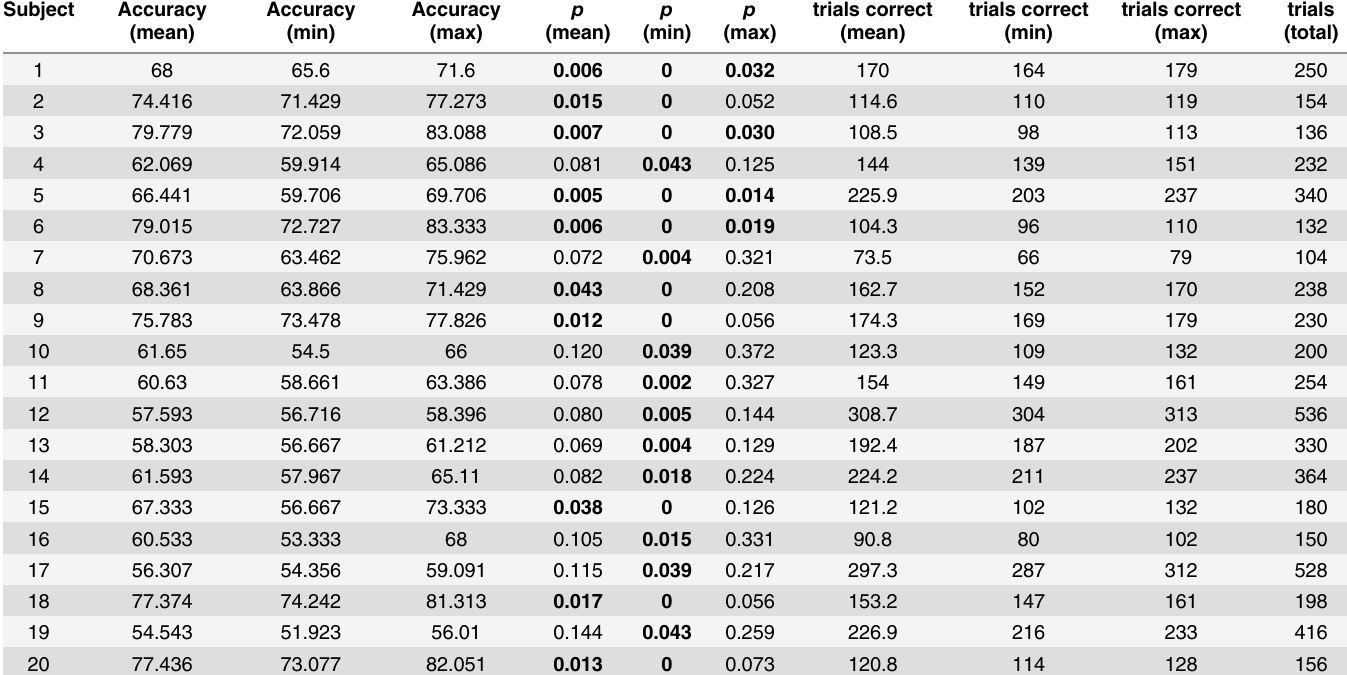
Table 7. Results Across Task: Train Flanker, Classify